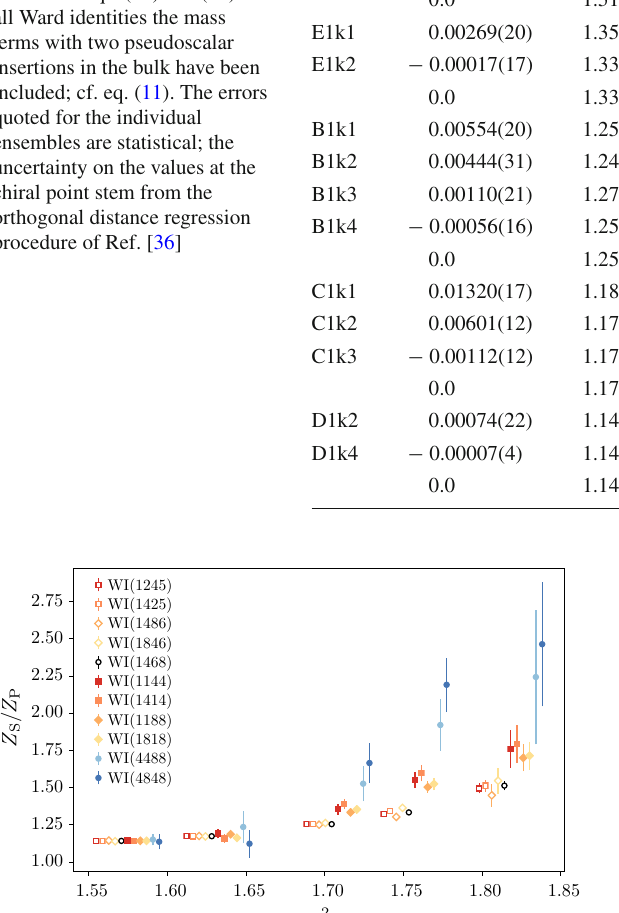
Table 5 Summary of results for am and Z S / Z P from different Ward identity determinations, labelled by WI( abcd ). The Ward identity linear combinations L 1 and L 2 are defined in Eqs. (32) and (33). In all Ward identities the mass terms with two pseudoscalar insertions in the bulk have been included; cf. eq. (11). The errors quoted for the individual ensembles are statistical; the uncertainty on the values at the chiral point stem from the orthogonal distance regression procedure of Ref. [36]